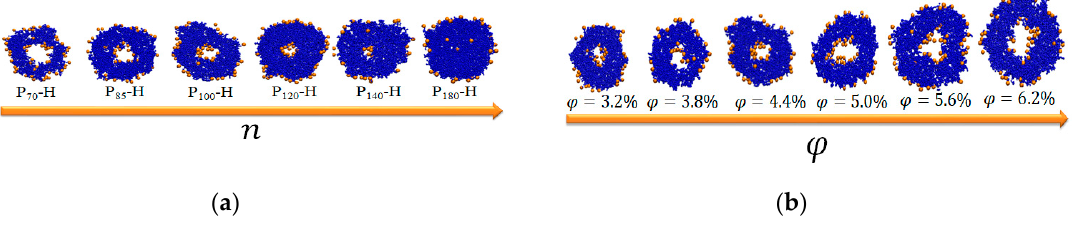
Figure 6. ( a ) Cross-sectional slices of the aggregates formed by P 70 –H, P 85 –H, P 100 –H, P 120 –H, P 140 –H and P 180 –H and the amphiphile concentration ϕ = 4.4%. ( b ) Cross-sectional slices of the aggregates formed by P 100 –H amphiphiles and di ff erent amphiphile concentration ϕ = 3.2%, ϕ = 3.8%, ϕ = 4.4%, ϕ = 5.0%, ϕ = 5.6% and ϕ = 6.2%. The orange and blue beads represent hydrophilic nanoparticle and hydrophobic polymer tail, respectively. Table 2. Summary of the inner and outer membrane radius and of the bilayer thickness with di ff erent amphiphile concentration for P 100 –H at T ∗ =